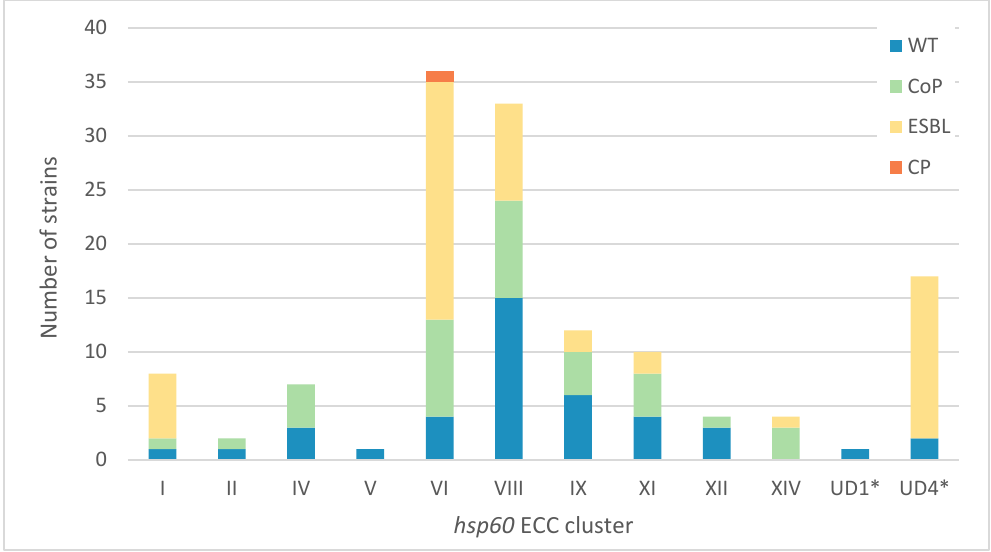
Figure 1. Distribution of 135 E. cloacae complex (ECC) members isolated from clinical samples according to the hps60 approach. For each hsp60 cluster recovered in this bacterial collection, nosocomial strains were grouped according to their resistance profile to β -lactam antibiotics: wild-type (WT), extended-spectrum- β -lactamase (ESBL), cephalosporinase overproduction without ESBL gene (CoP), or carbapenemase production (CP). The distributions in Figure S3 and the hsp60ECCtool output were identical (for details see Supplementary Data Set S1). Cluster XIV was defined according to Beyrouthy et al. and corresponds to E quasihormaechei [2,3,6]. * UD refers to “undefined hsp60 cluster” [18]. They were not identified in the original paper of Hoffman et al. [4].